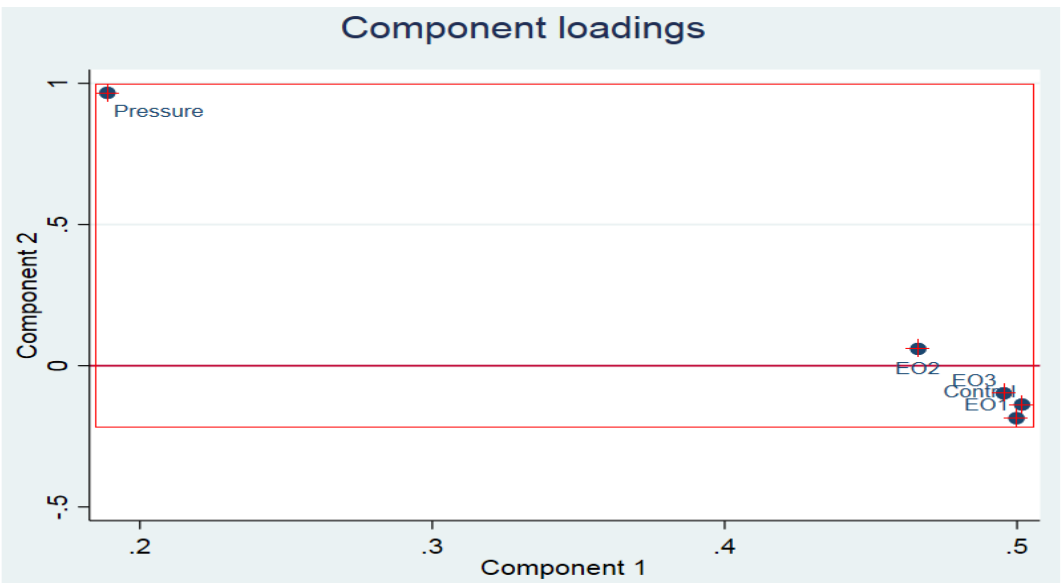
Figure 3. Plotting of the observations related to the FTIR spectral data of the variables (control: PLA films, EO1: PLA films incorporated with 0.5% of anise EO (PLA/0.5AE), EO2: PLA films incorporated with 1% of anise EO (PLA/1AE), EO3: PLA films incorporated with 1.5% of anise EO (PLA/1.5AE)) loaded on the multidimensional space of PCA as principal components 1 and 2 (PC1 and PC2). In particular, 0.2 or 20% of the pressure (indication of the successive passing of the tolerance test) on PC 1 and nearly 100% ( ≥ 97%) of the pressure on PC2 are